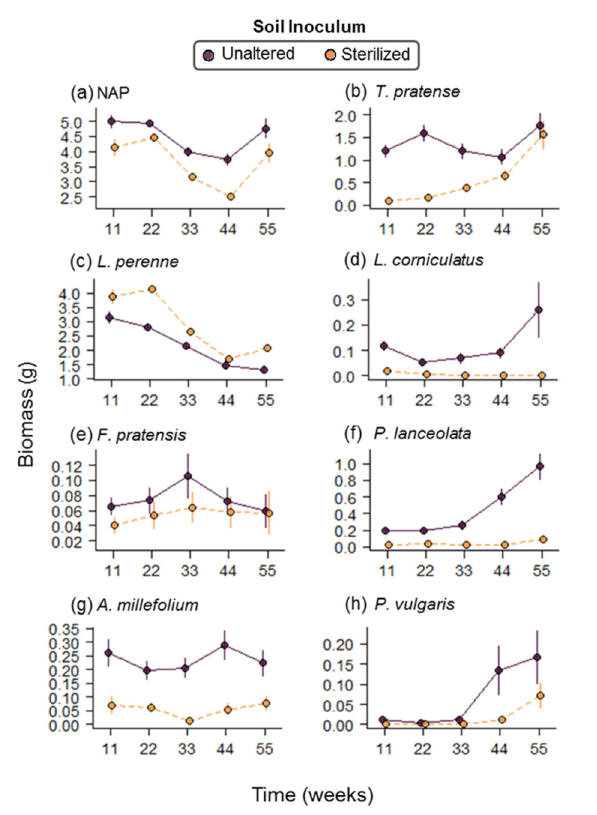
Fig 1. Net and species specific productivity when inoculated with the sterilized and unaltered soil inoculum. Means with standard errors of the mean are shown for (a) NAP and (b – h) the individual plant species at each harvest when grown with sterilized soil inoculum (light points, dashed line) or unaltered soil inoculum (dark points, solid line). Lines connecting means highlight the trend between consecutive harvest time